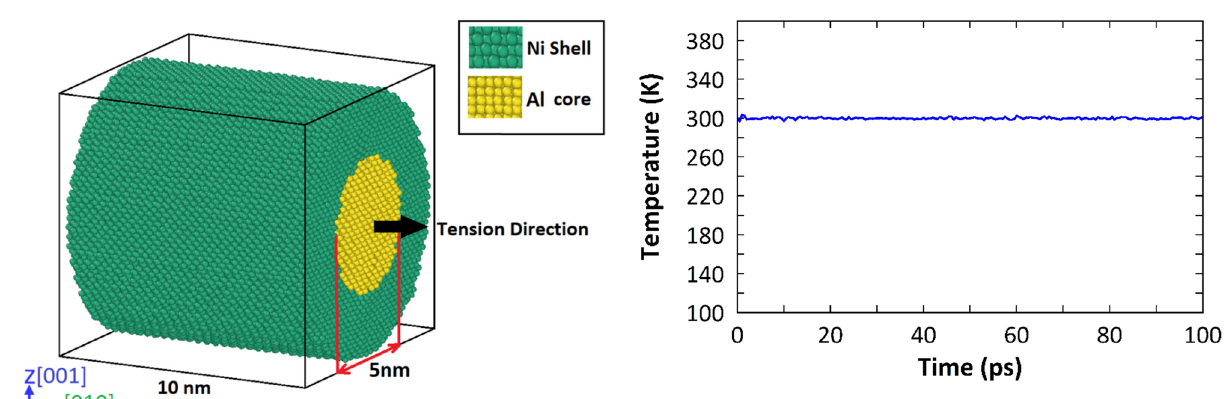
Figure 3: Temperature fl uctuation during